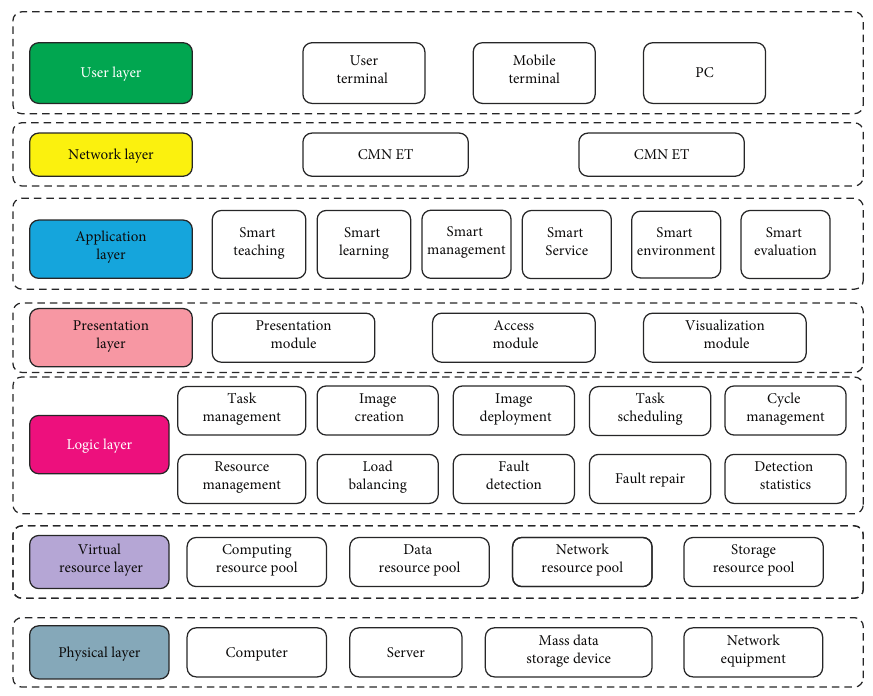
Figure 2: The structure diagram of the tourism teaching and training system based on the adaptive virtual queue algorithm.